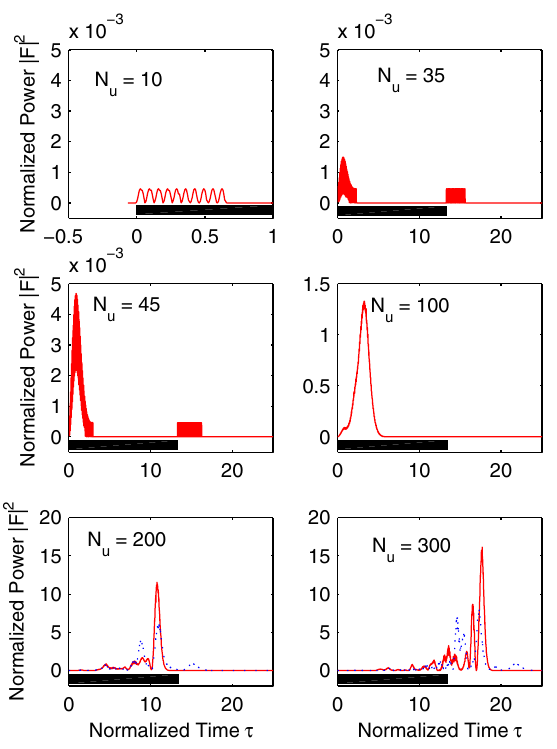
FIG. 4. Normalized power vs normalized time at different longitudinal positions in the undulator. The solid red curves depict the results for simulations without shot noise whereas the dotted blues curves depict the simulations that take into account shot noise. The arrival time of electrons is shown by the black boxes lying under the abscissas. Note that there are differ- ent scales on the plots.